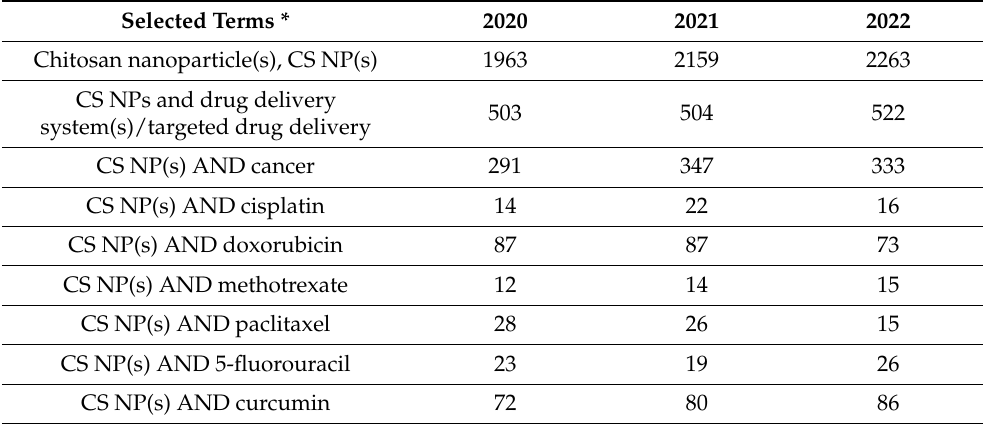
Table 1. The number of original articles on chitosan nanoparticles, including drug delivery systems and selected anticancer drugs, based on data from the Scopus database (15 December 2022)